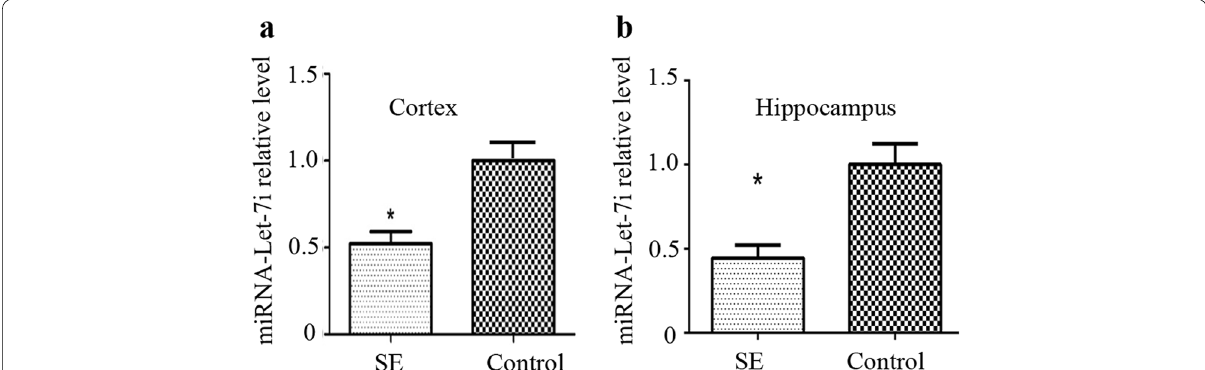
Fig. 1 RT-qPCR analysis of miRNA-Let-7i expression in the pilocarpine-induced SE model rats. Compared with the control group, miRNA-Let-7i expression in the SE group was reduced in both the cortex and the hippocampus (* P < 0.05 versus control group; n